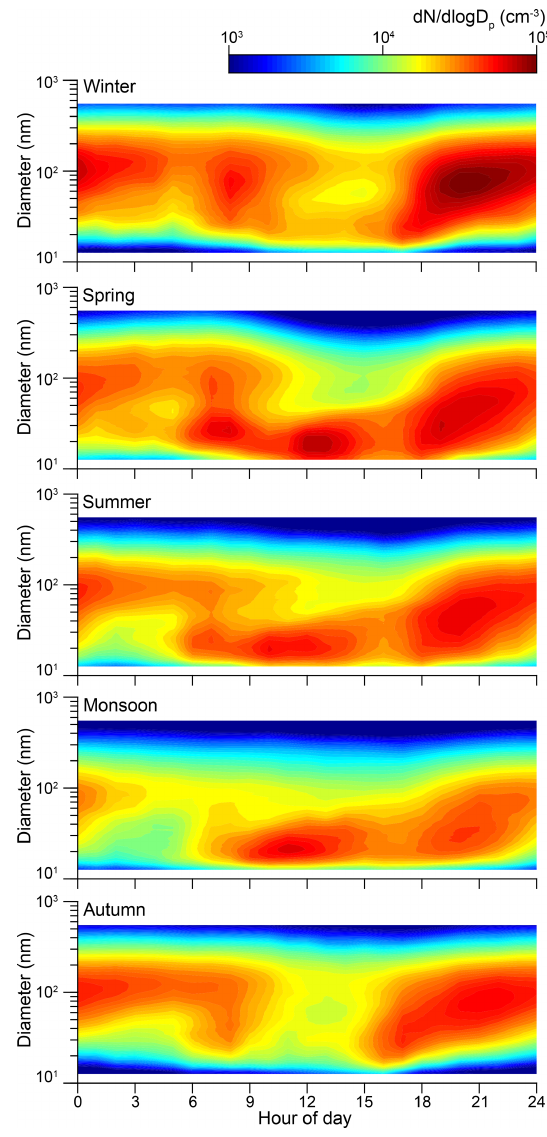
Figure 6. Heat map for particles between 12 and 560nm averaged for each